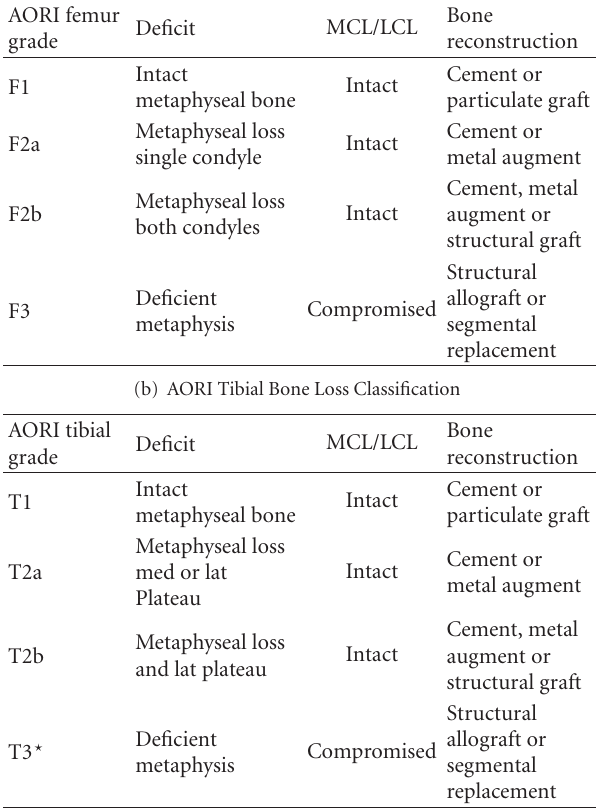
Table 1: Classification of femoral and tibial bone loss [1].